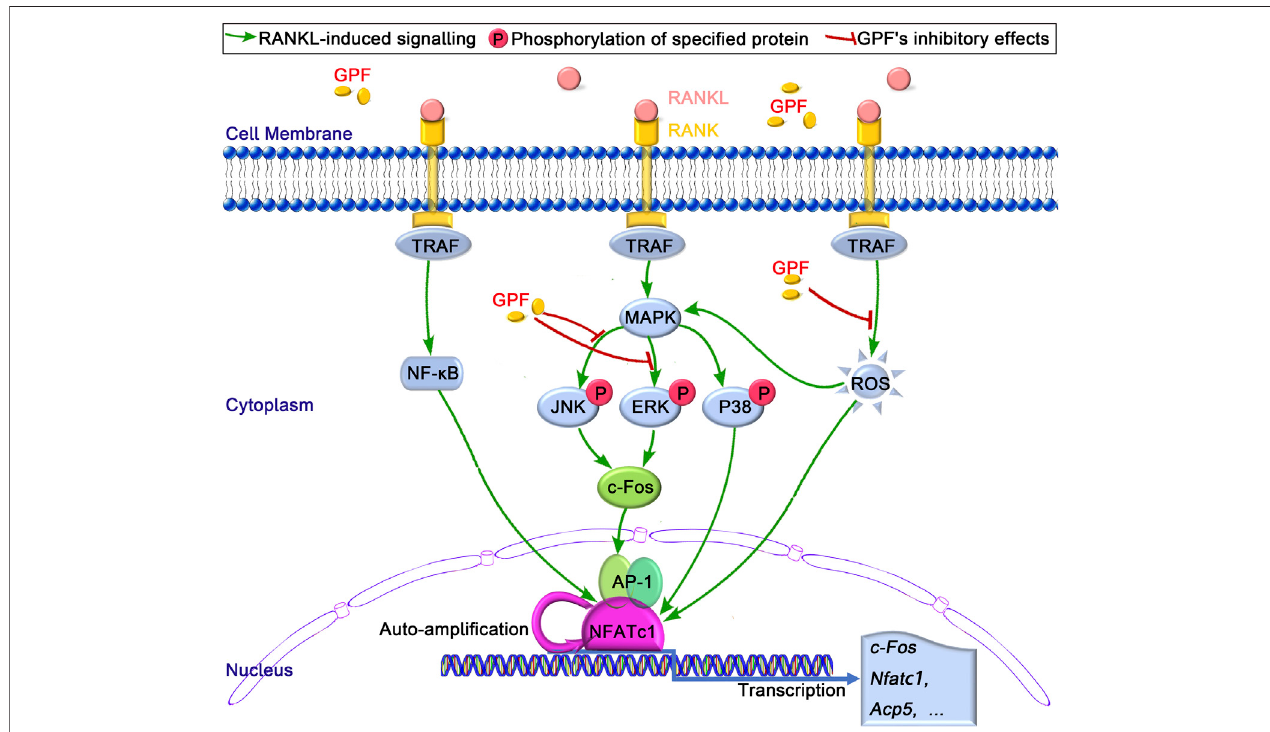
FIGURE 6 | The proposed mechanism by which GPF inhibits osteoclastogenesis. Binding of RANKL to its receptor RANK, results in the recruitment of TRAF, following by the activation of MAPK and NF- κ B pathways and the subsequent self-ampli fi cation of NFATc1. As a result, several osteoclast-speci fi c genes, including c-Fos , Acp5 , and NFATc1 are upregulated. These signaling events are regulated by RANKL-activated ROS signaling. Our results indicated that GPF can inhibit osteoclast formation and bone resorption via suppressing MAPK (ERK and JNK)/c-Fos/NFATc1 signaling pathways and scavenging ROS activities.